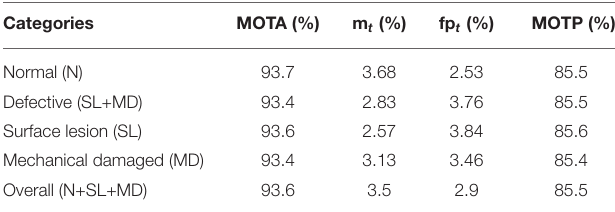
TABLE 2 | Performance evaluation of the combination of the detector and